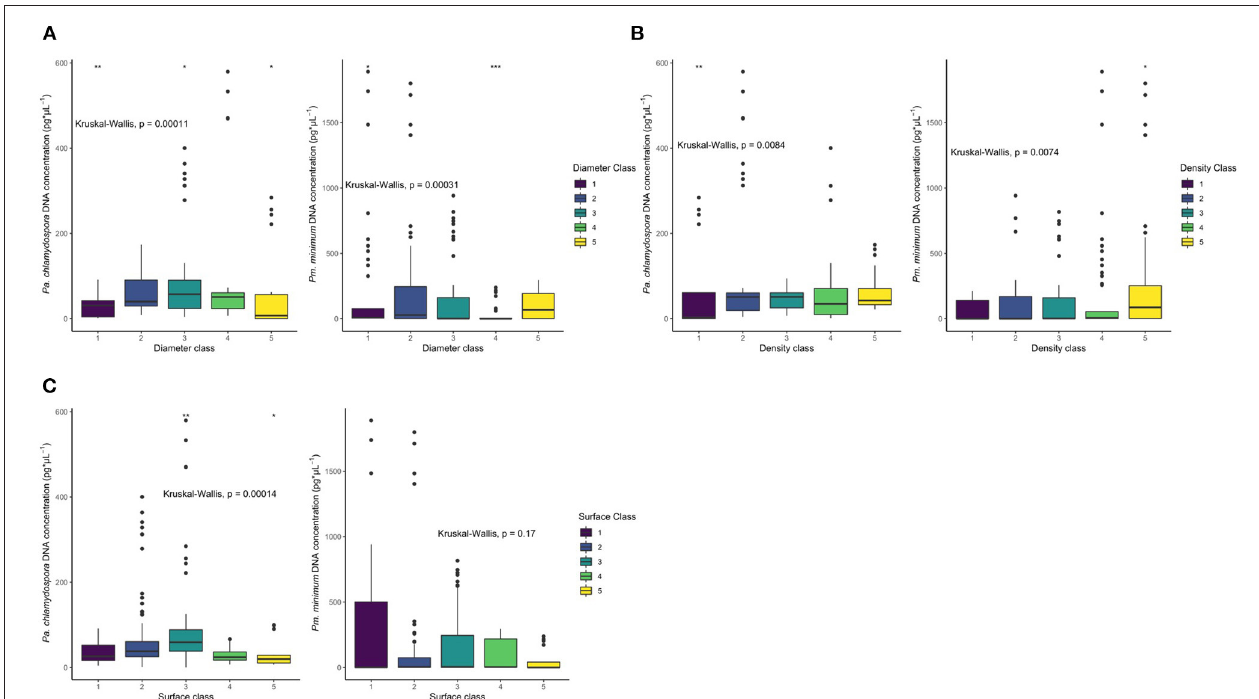
FIGURE 6 | Box plots of the fungal DNA concentration for each histological group. (A) The fungal DNA concentration in pg/ µ l for each diameter class ( < 44, 45–54, 55–64, 65–74, and 75–84 µ m, respectively). Left: Pa. chlamydospora . Right: Pm. minimum. Color-coded by diameter class. (B) The fungal DNA concentration in pg/ µ l for each density class [ < 36, 37–46, 47–56, 57–66, 67, and above (vessels/ mm 2 ), respectively]. Left: Pa. chlamydospore. Right: Pm. minimum. Color-coded by density class. (C) The fungal DNA concentration in pg/ µ l for each surface class [0.10–0.14, 0.15–0.19, 0.20–24, 0.24–0.30, 0.31 and above (xylem/total mm 2 ), respectively]. Left: Pa. chlamydospora . Right: Pm. minimum. Color-coded by Surface class. Surface classes are non-significant for Pm. minimum ( P < 0.05). Significance (* P < 0.05, ** P < 0.01, *** P < 0.001) determined by the Wilcoxon rank sum